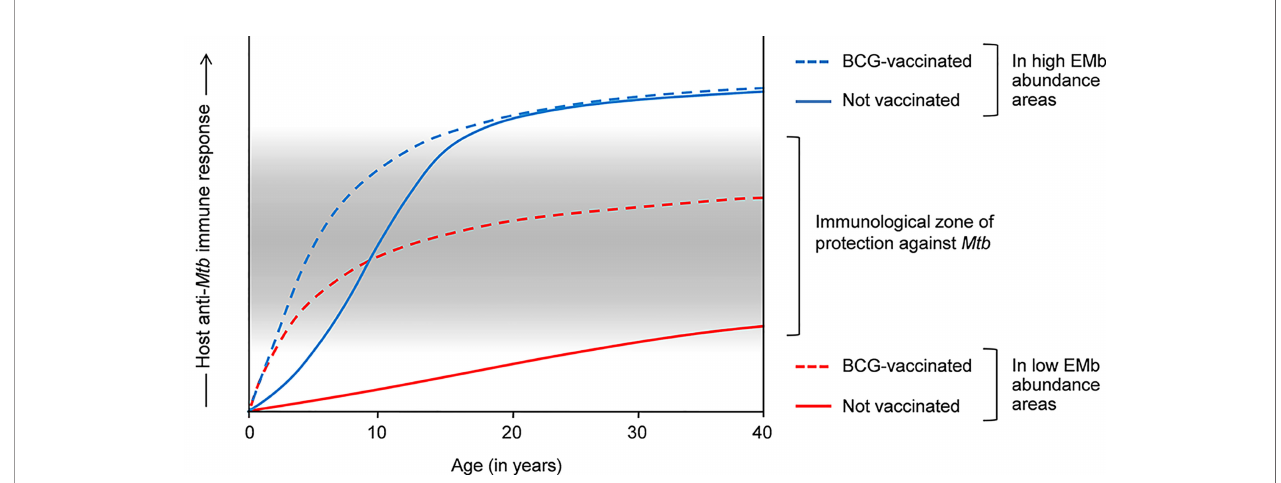
FIGURE 1 | Effects of environmental mycobacteria (EMb) and BCG on the host response to Mtb and the cross-talk thereof. Host response to Mtb is complex and heterogeneous. Infants and young children have a poorly developed immune system, which is incompetent in containing Mtb infection. BCG vaccination in these people promotes T H 1 responses to Mtb , resulting in the effective containment of the bacilli and signi fi cant protection against childhood TB (dashed blue and red lines). Owing to the presence of cross-reactive antigens, EMb also activate a degree of immunity against Mtb and therefore, confer some protection against childhood TB (blue line). However, frequent EMb exposure leads to the aggravation of anti- Mtb immunity in immunocompetent adults, which drives TB pathogenesis and results in higher incidence of pulmonary TB in the EMb-abundant areas (normal blue line). Similar aggravation of anti- Mtb immunity occurs in BCG-vaccinated adults in the EMb-abundant areas and leads to higher incidence of adult pulmonary TB and low ef fi cacy of BCG in these places (dashed blue line). On the other hand, owing to low EMb exposure, BCG-mediated immunity against Mtb is not substantially modulated in the adult inhabitants in the areas of lower EMb abundance (dashed red line). Accordingly, vaccinated adults exhibit a moderately intense anti- Mtb immune response, which confers signi fi cant protection against adult pulmonary TB in these